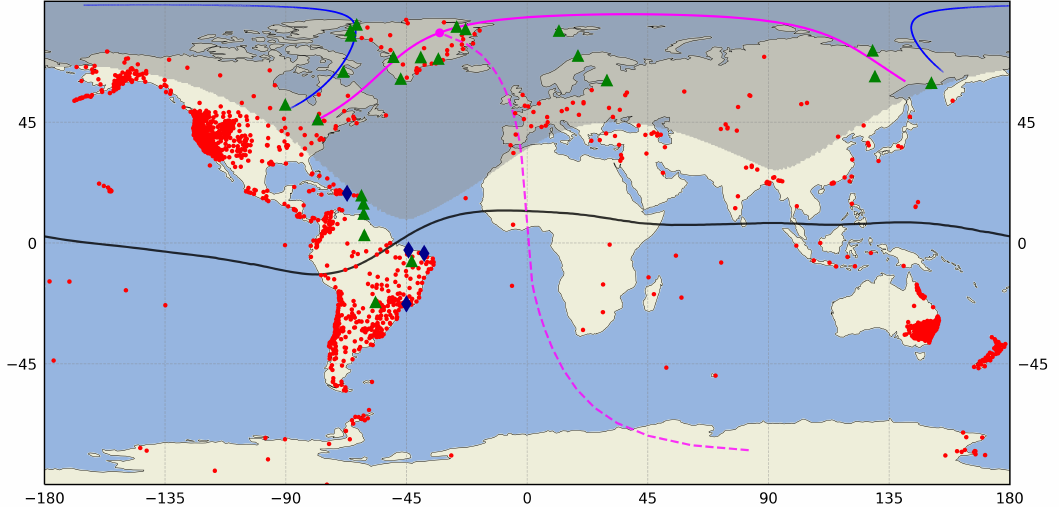
Figure 1. Instruments used in present work: 2337 GNSS stations (red dots), 4 digisondes (blue rhombuses), and 24 selected GNSS stations (green triangles). The magnetic equator (black line) and the annular eclipse path at ground level (blue line) are shown. Eclipse obscuration mask from P1–P4 time (shaded region), the annular solar eclipse path (magenta line), the maximum obscuration (magenta dot) at 350 km altitude are presented. The magenta dashed line starts from the maximum obscuration of the solar eclipse to its conjugate location in the Southern